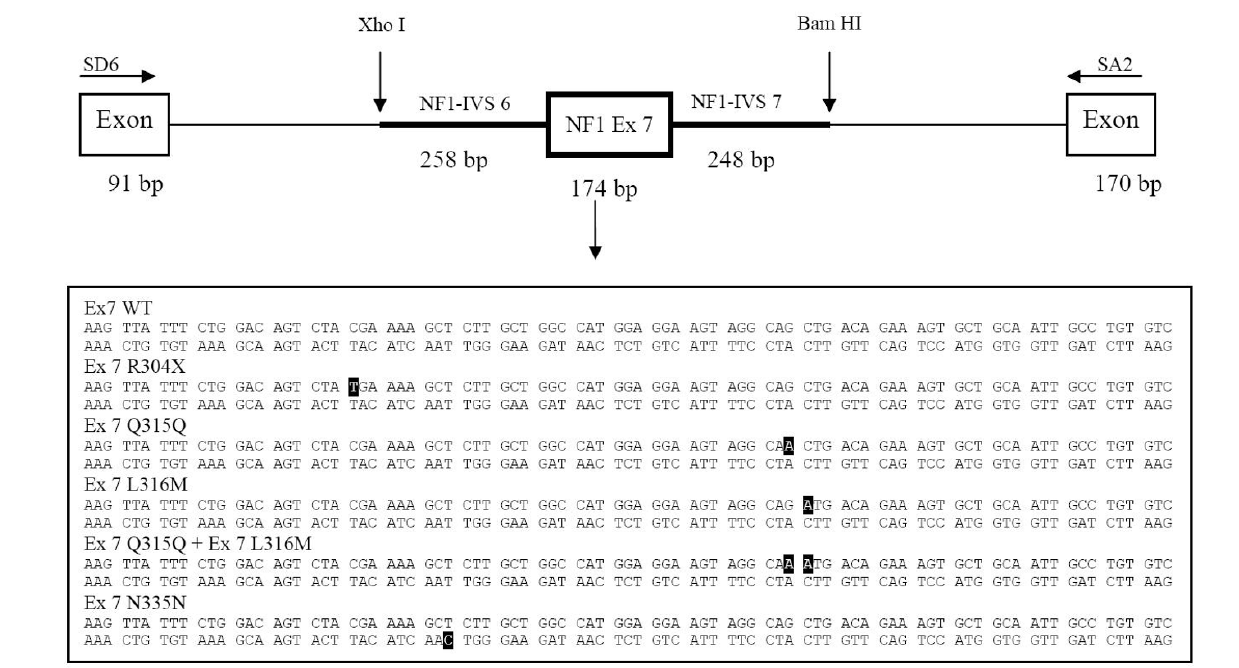
Figure 2 Representation of the pSPL3-NF1-7 minigene construct. Genomic sequence from exon 7 of the NF1 gene along with 258 bp of 5' and 248 bp of 3' intronic flanking sequence was ligated into pSPL3 plasmid. Shaded sequences describe the nucleotide changes introduced independently by in vitro mutagenesis to obtain the mutated